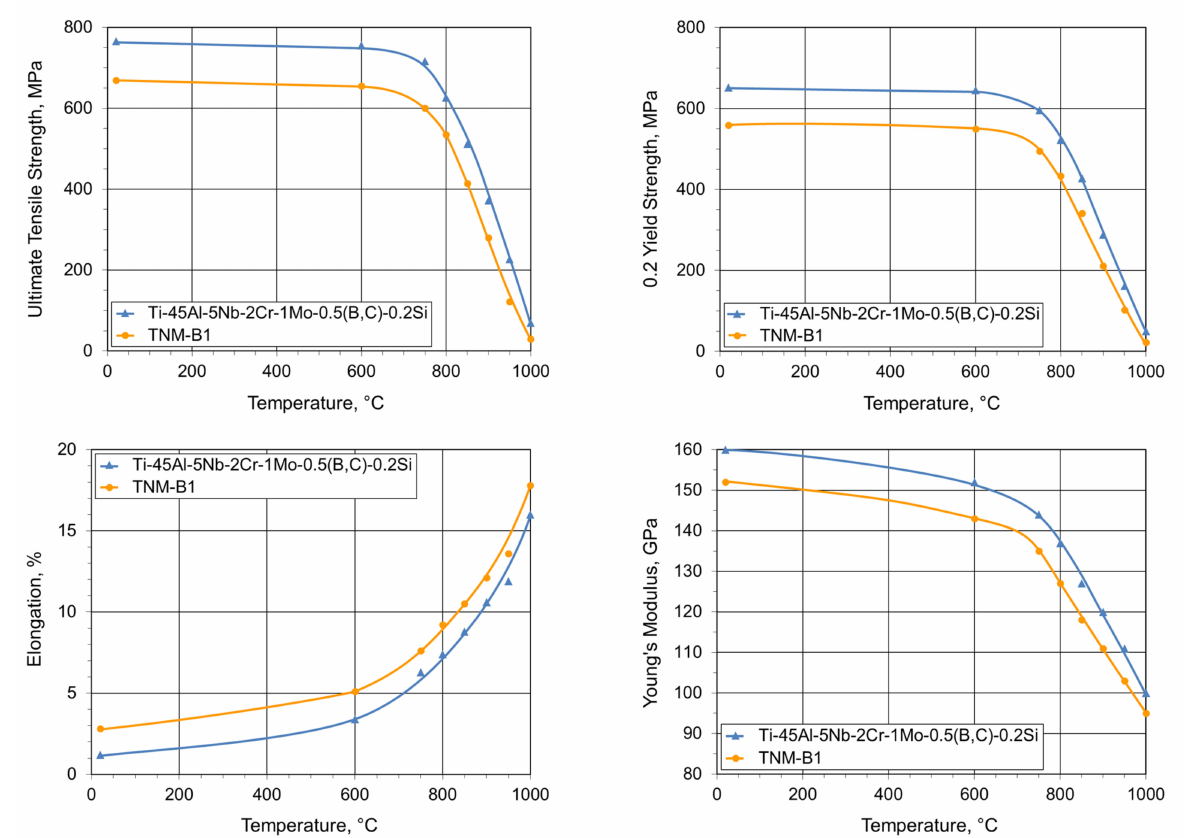
Figure 11. Ultimate tensile strength, 0.2% yield strength, elongation, and Young’s modulus of Ti-45Al-5Nb-2Cr-1Mo- 0.5(B,C)-0.2Si alloy at temperature between 20 and 1000 ◦